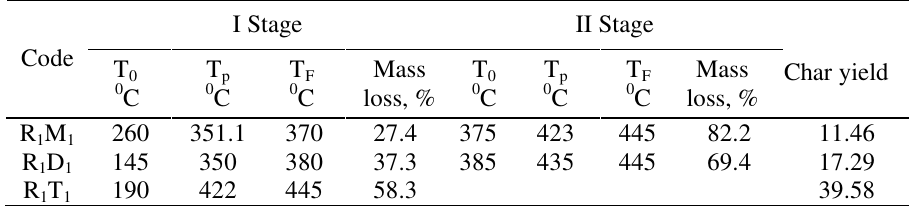
Table 4. Thermal behavior of isothermally cured blends of Epoxy acrylate resin / monomers (heating rate 20 0